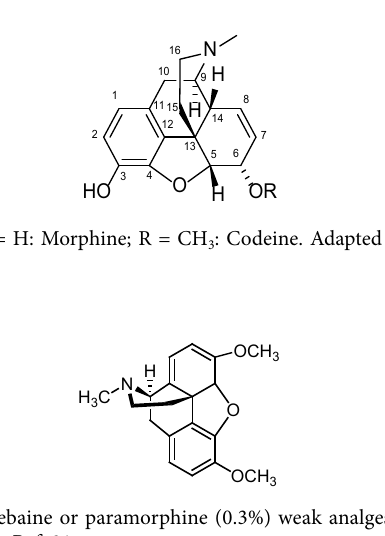
Figure 7. Thebaine or paramorphine (0.3%) weak analgesic action. Adapted from Ref. 21.